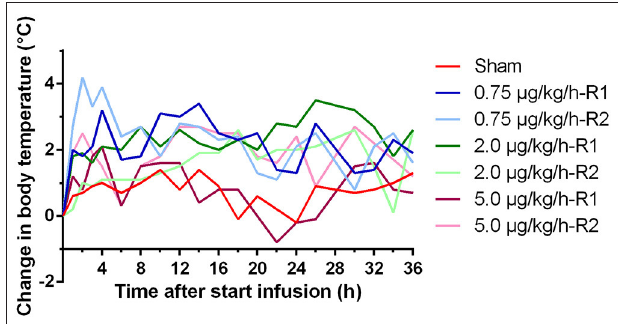
FIGURE 1 | Change in body temperature over time during a 36h continuous intravenous infusion of either 0.9% NaCl solution (6 ml/kg/h, sham, n = 1) or 0.9% NaCl solution (6 ml/kg/h) in combination with LPS (0.75; 2.0, and 5.0 µ g/kg/h, n = 2/group). The change in body temperature is calculated as the difference between the body temperature at each time point and the temperature just before the start of the infusion. R1 and R2 present two replicates for each